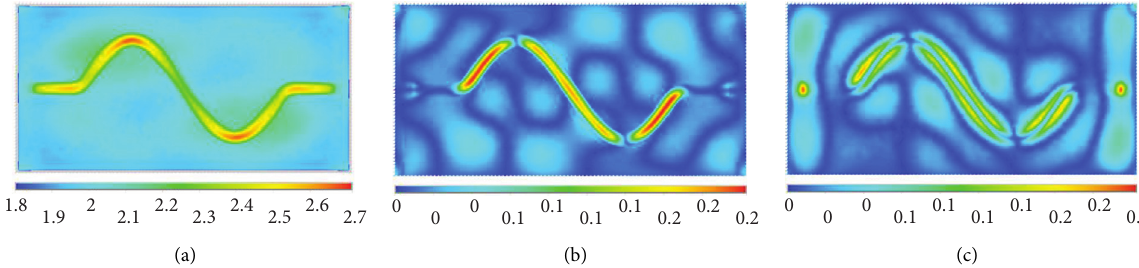
Figure 12: SV wave incident ( f � 1.0Hz, H � 100m, C